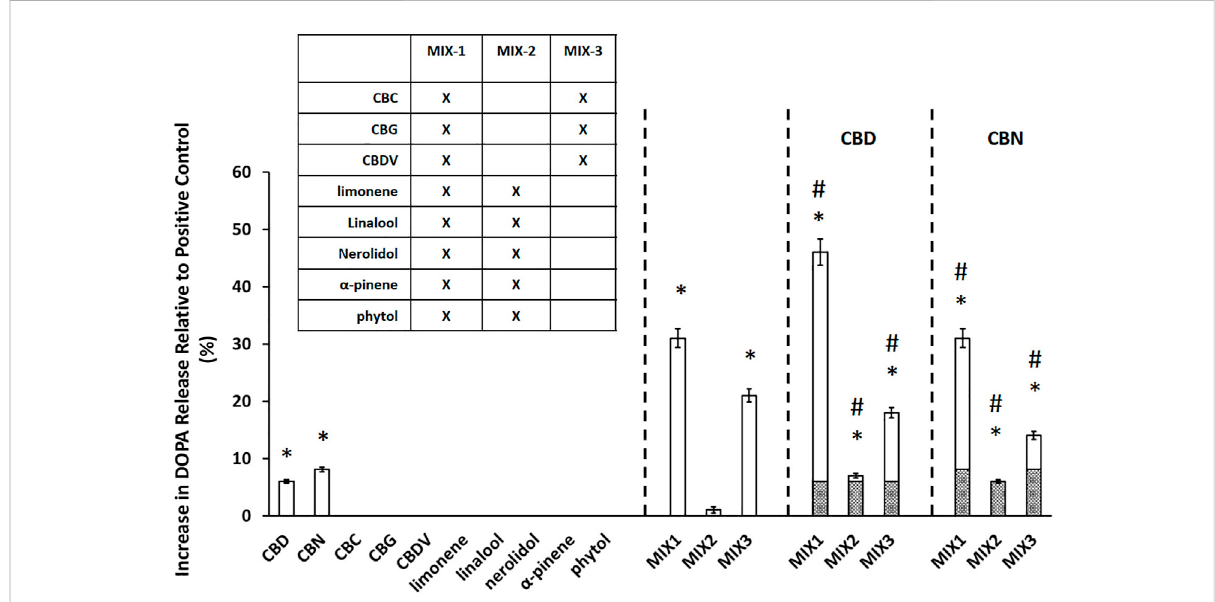
FIGURE 2 Cannabinoidsmixtureselicitsigni fi cantdopamine secretion. Theexperimentalvalueispresented asthenormalizedvalue,which isapercent of the positive control value (secretion achieved with PMA/Ionomycin application). An asterisk * indicates a p -value < 0.05 for the replicates relative to their respective vehiclecontrol replicates. MIX-1,MIX-2, and MIX-3 weretested without or withtheadditionofamajor cannabinoid (CBDorCBN). A hashtag #represents p < 0.05major cannabinoid vs. nativemixture.Calculated(hashed shading)predictionofef fi cacy basedonthesumofthe ef fi cacy of each ingredient measured separately and Measured (open shading) ef fi cacy were shown. Each data point in the fi gure represents the mean ± the standard deviation of twenty-four experimental results obtained at 10 µM of each major or minor cannabinoid and terpene (alone or in equimolar mixtures as described in the inset table in Panel B). Twenty-four experimental results were obtained by repeating eight independent experiments three times on three different days ( ” 8 × 3 ”